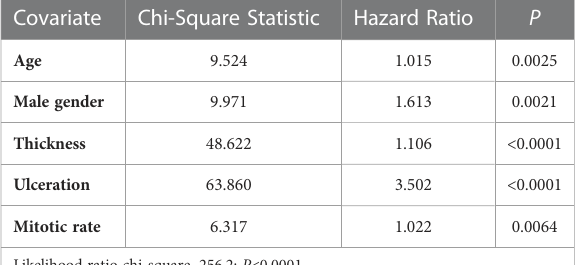
TABLE 2 Effect of mitotic rate as a continuous variable on melanoma-speci fi c mortality. Covariate